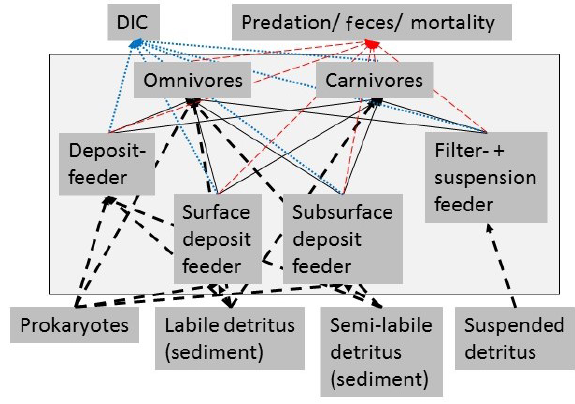
Figure 3. Simplified schematic representation of the food web structure that forms the basis of the linear inverse model (LIM). All compartments inside the box were part of the food web model, whereas compartments outside the black box were only considered as carbon influx or efflux, but were not directly modeled. In or- der to simplify the graph, for macrofauna, polychaetes, and inver- tebrate megafauna, only feeding types were presented and no size classes. Solid black arrows represent the carbon flux between food- web compartments and black dashed arrows represent the influx of carbon to the model. Blue-dotted arrows show the loss of carbon from the food web via respiration to DIC. The red dashed arrows indicate the loss of carbon from the food web as feces and as preda- tion by pelagic/benthopelagic